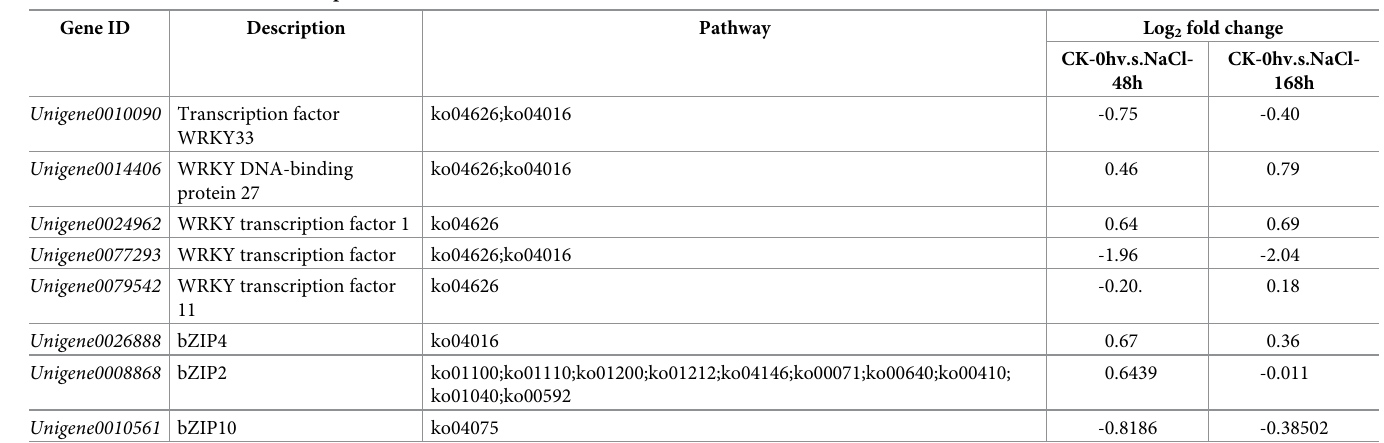
Table 6. Gene annotation of transcription